Question: According to the figure, is the described quantity increasing or decreasing?
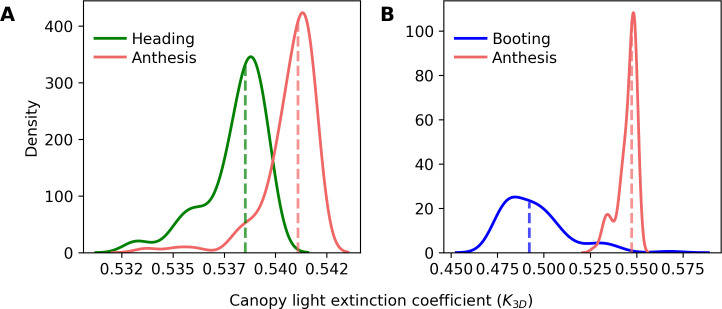
Answer: increasing